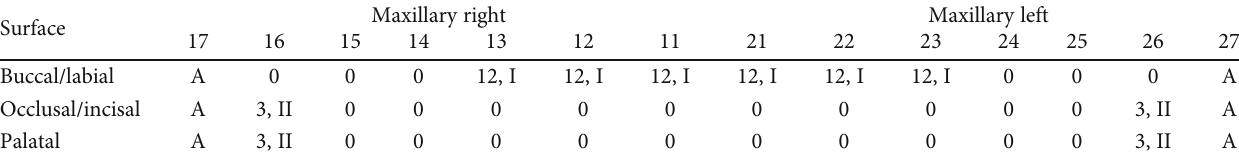
Table 1: Assessment of the clinical status and extent of MIH along with other enamel defects in maxillary teeth. Surface